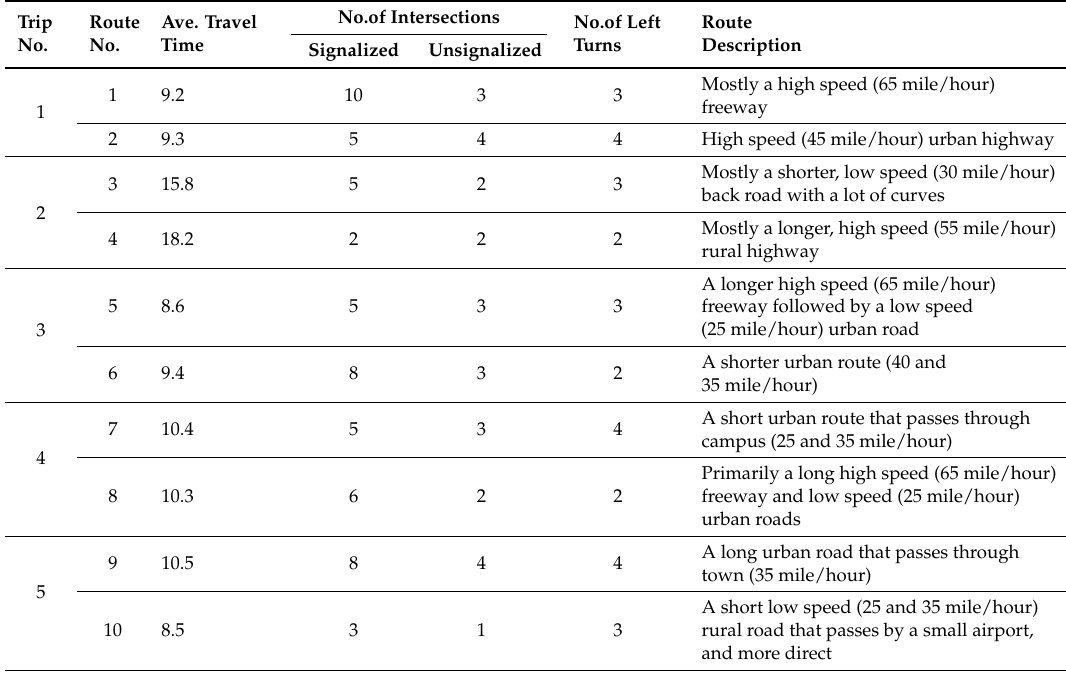
Table 2. Route characteristics of each O-D